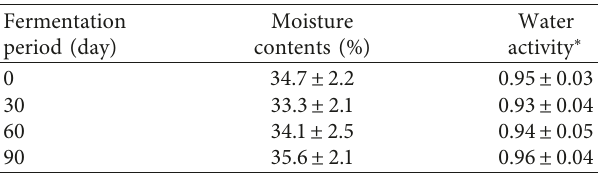
nitrogen-free extract. Table 2: Moisture contents and water activity of olive cake during 90 days of fermentation.